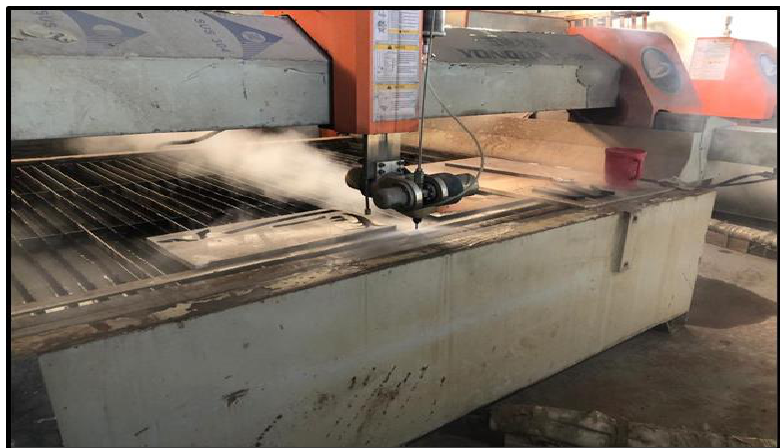
Figure 2: Experimental setup for abrasive water jet machining.